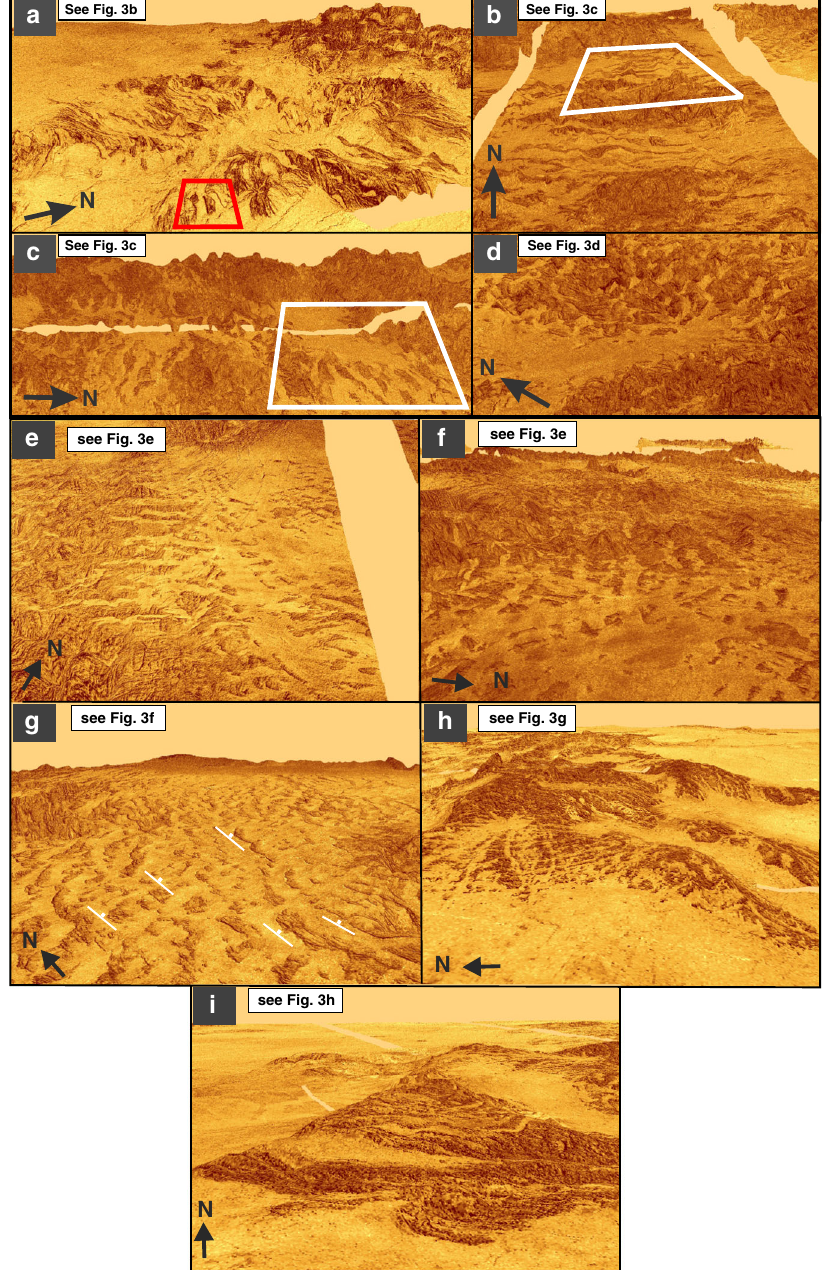
Fig. 4 Elevated oblique 3-D views of tesserae fl ooded by ma fi c lavas. Images were generated from SAR images draped on the Magellan altimetry topography using the software ArcScene (vertical exaggeration 20×). These images correspond to the areas shown in Fig. 3: a corresponds to area of Fig. 3b viewed from east (red box explained in Figs. 3b and 5 and discussed in text); b Fig. 3c viewed from south (white box gives approximate location